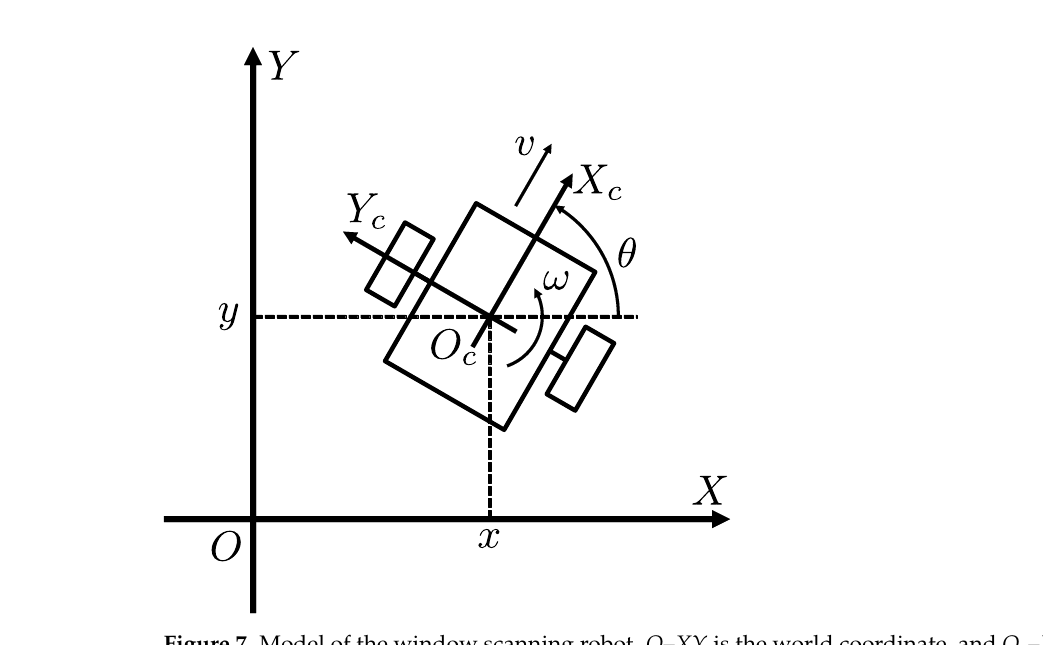
Figure 7. Model of the window scanning robot. O – XY is the world coordinate, and O c – X c Y c is the fixed coordinate to the robot, where O c is located on the center of the wheel shaft and Y c is along the